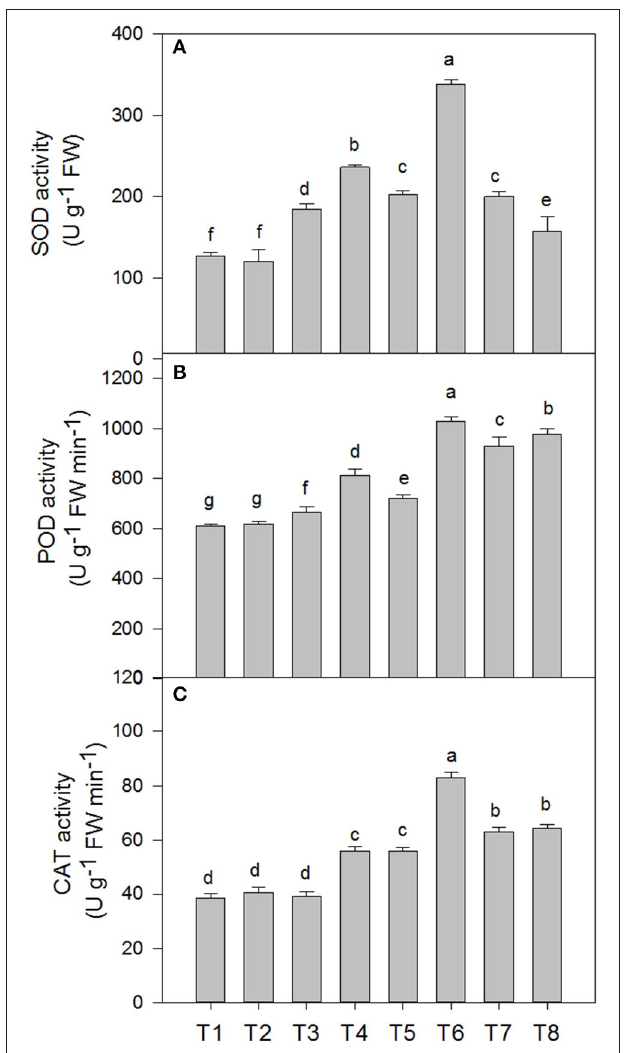
FIGURE 5 | Effects of SA on the superoxide dismutase (SOD) (A), peroxidase (POD) (B) , and catalase (CAT) (C) activities of D . superbus grown under salt stress (means ± SD ). Different letters indicate significant differences ( P < 0.05) according to an LSD-test; the same letter indicates no significant differences between the treatments, n = 5.